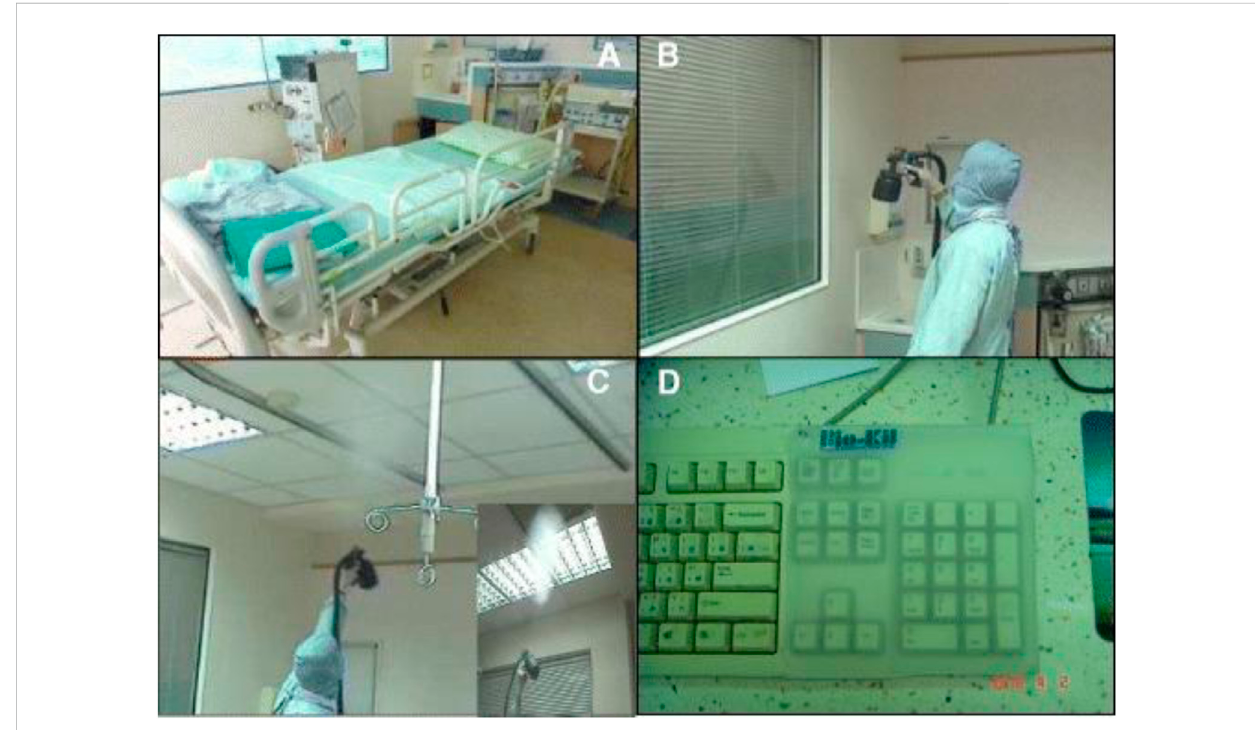
FIGURE 4 Application of Bio-Kil bacteria killing nanotechnology in the intensive care unit. (A) Ten sets of new textiles (pillow cases, bed sheets, duvet covers, andpatientclothing)wereprovidedbytheresearchersforbothS-19andS-20.Clothingforfamilymembers,nurses,anddoctorswereroutinelyprovided bythehospital. Allthetextiles placedinS-20 weretreatedbyBio-Kilsolution. (B) AllroomwallsinS-20weretreatedevenlywith Bio-Kilsolution. (C) Bio- Kil solution was sprayed evenly on the air fi lter and the ceiling in S-20. (D) A Bio-Kil antibacterial silicon pad (50 cm × 50 cm) was placed over the instrument panel and computer keyboard in the nursing station in the S-20 ward. Reproduced with permission from (Hsueh et al.,